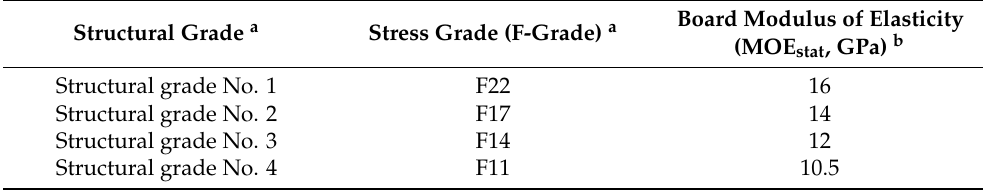
Table 1. Structural grades assigned to the sawn boards after mechanical testing according to (Aus- tralian Standard) AS 4063.1 [17] and the corresponding Modulus of Elasticity (MOE) outlined in the Australian Standard 1720.1, Table